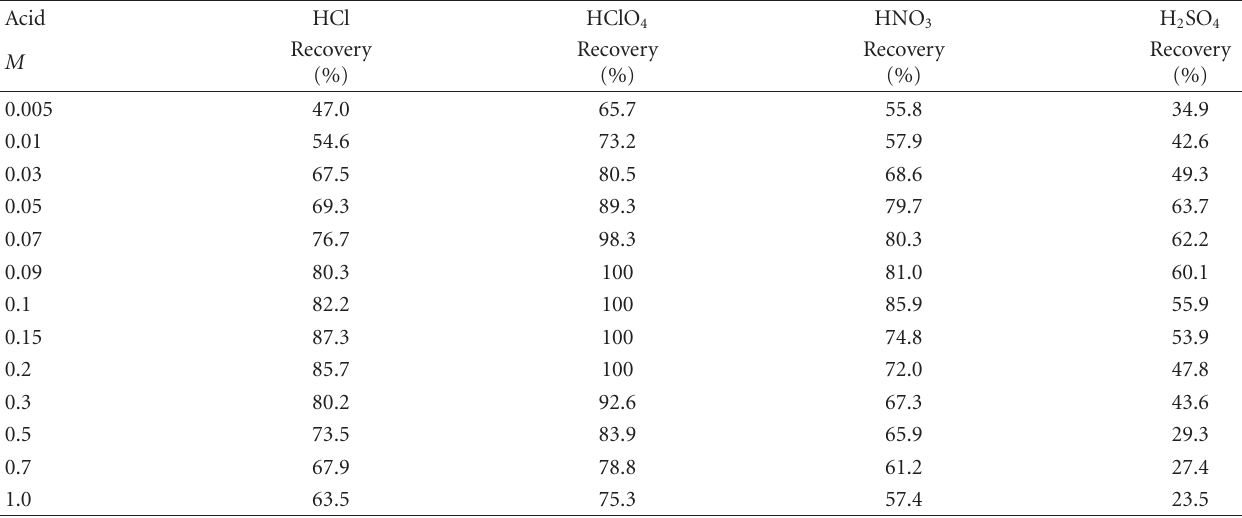
Table 4: Extraction behaviour of neodymium(III) as a function of stripping agents. Nd(III) = 60 μ g, sodium succinate = 0.06 M, pH = 6.0,